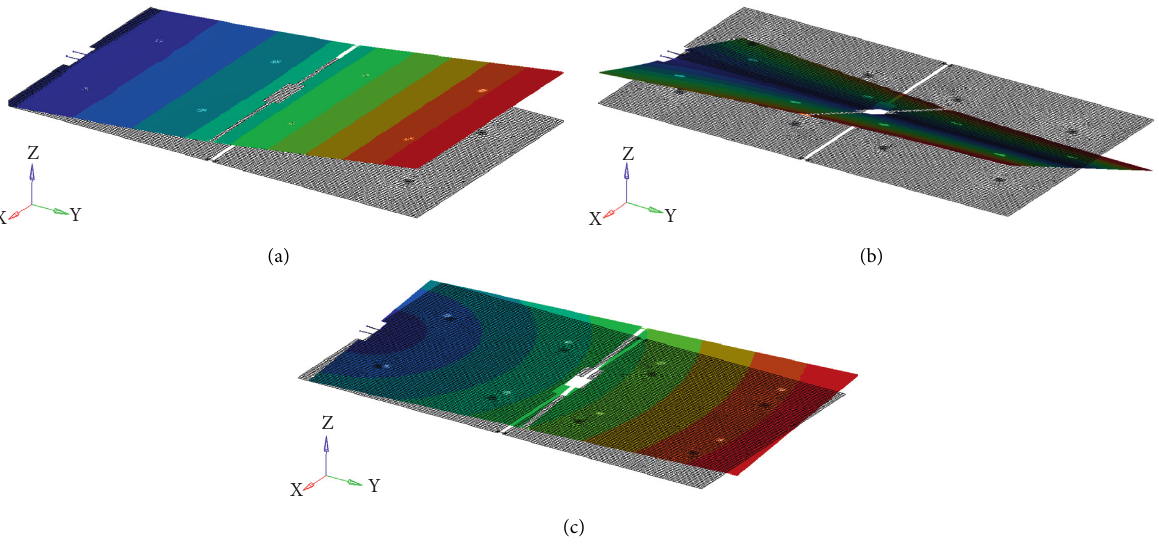
Figure 7: First three-order modes of the twofold solar array of PCB plates: (a) mode 1: freq. � 0.7 377 Hz; (b) mode 2: freq. � 3.2 057 Hz; (c) mode 3: freq. � 3.5 942 Hz.